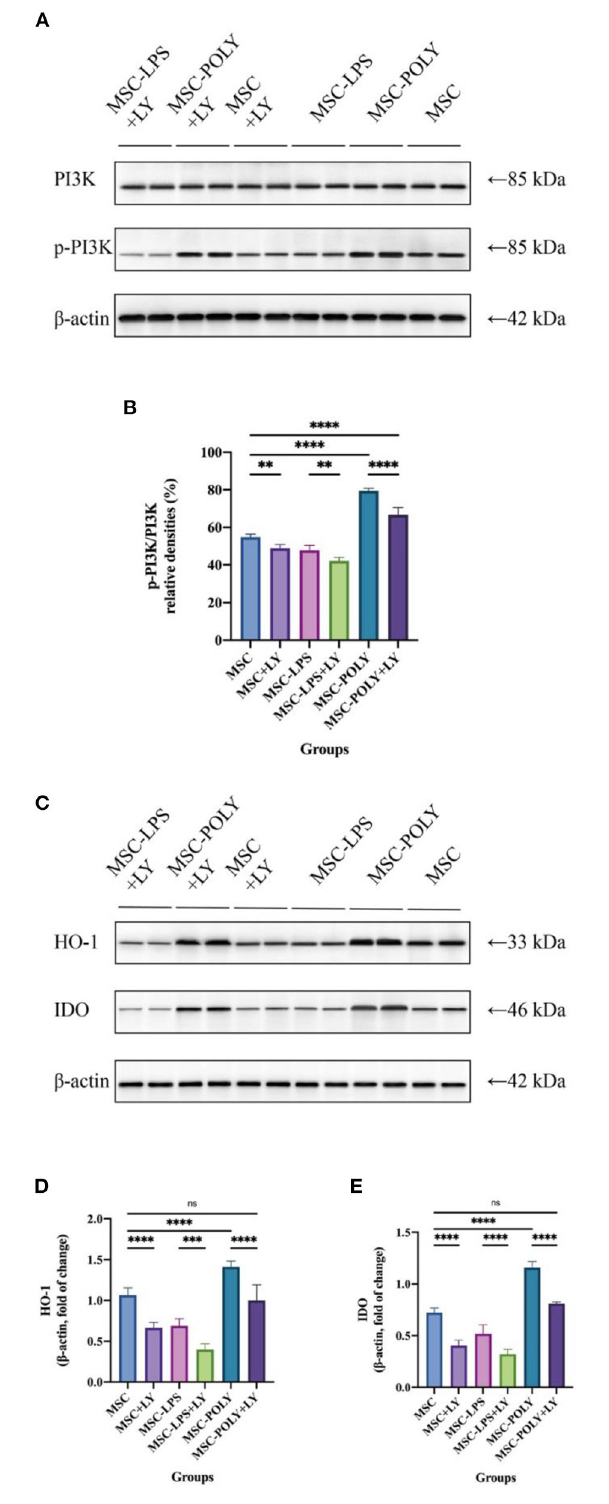
FIGURE 6 | Inhibition of PI3K and protein secretion of IDO-1 and HO-1 in mesenchymal stem cells after addition of the PI3K inhibitor.